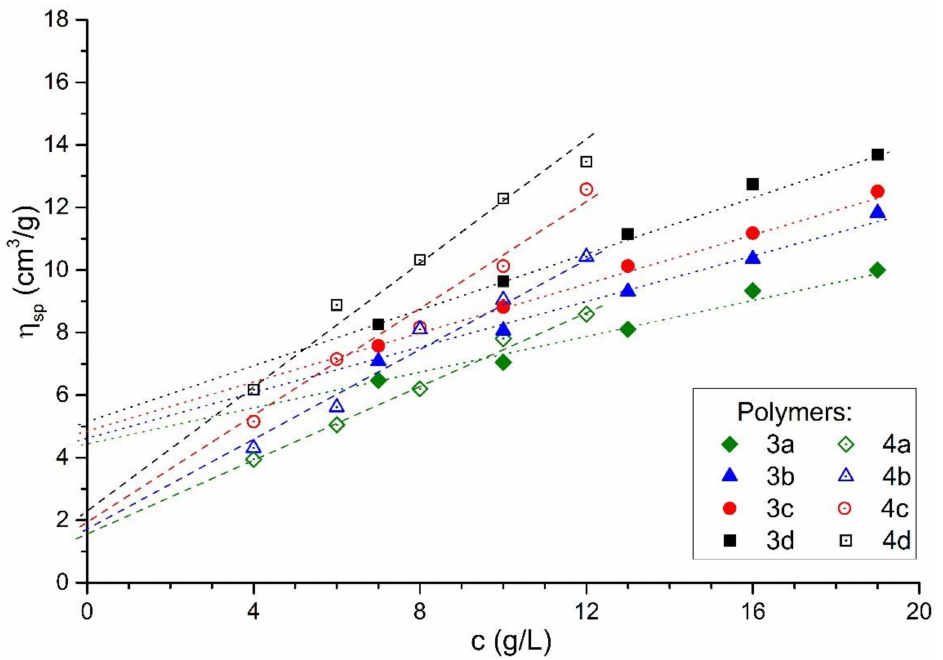
Figure 8. Specific viscosity of silatrane-containing polymers as a function of concentration in tetrahy- drofurane at 25 ◦ C.